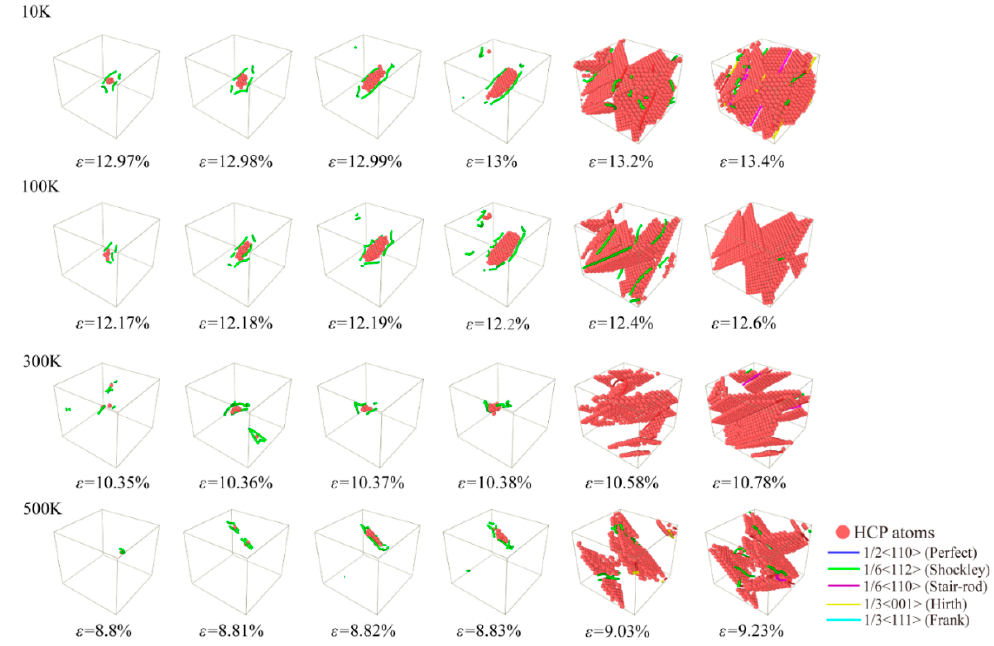
Figure 12. Atomic configuration snapshots of the systems under different compression strains ε for Al-2%Mg alloy with background temperature span from 10 K to 500 K. The red atoms represent HCP atoms.